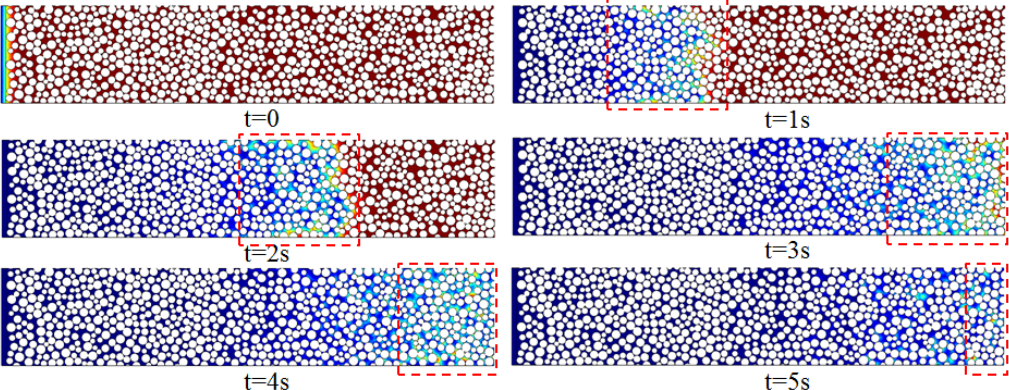
Figure 2. Distribution of grout suspension at different times .